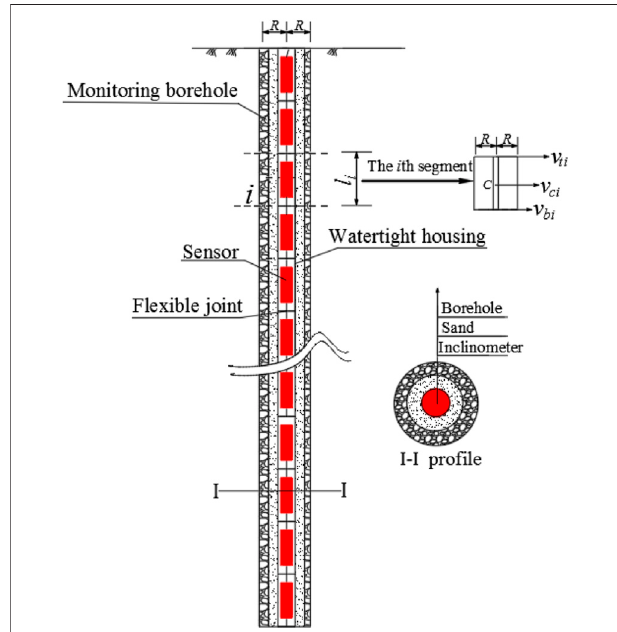
FIGURE 3 | MEMS-based in-place inclinometer is composed of a series of MEMS accelerometer sensors separated variously by fl exible joints and encased in a watertight housing. The main steps of installation are drilling, putting the MEMS-based in-place inclinometer into the monitoring borehole, back fi lling with